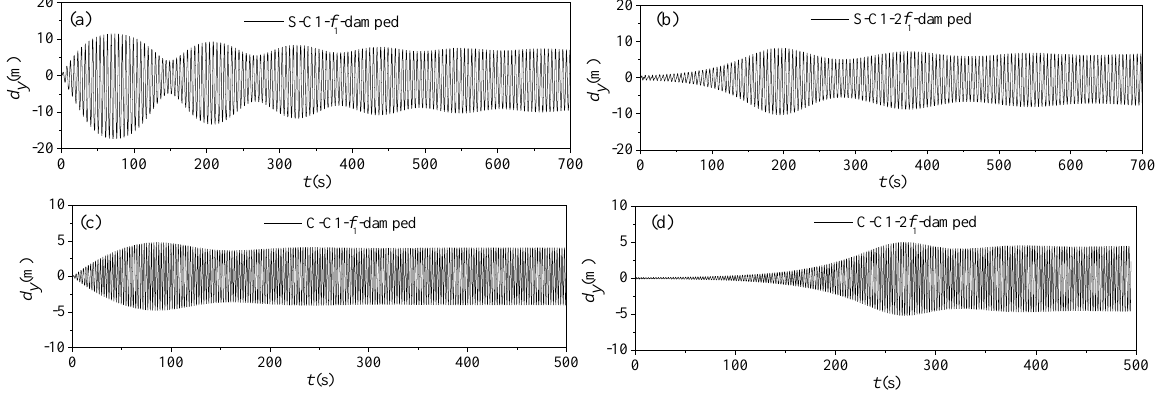
Figure 13. Parametric vibration response of stay cable C1 (damped): ( a ) steel cable under excitation frequency f = f ; ( b ) steel cable under excitation frequency f = 2 f 1 cable under excitation frequency f = f ; ( d ) CFRP cable under excitation frequency f = 2 f 1